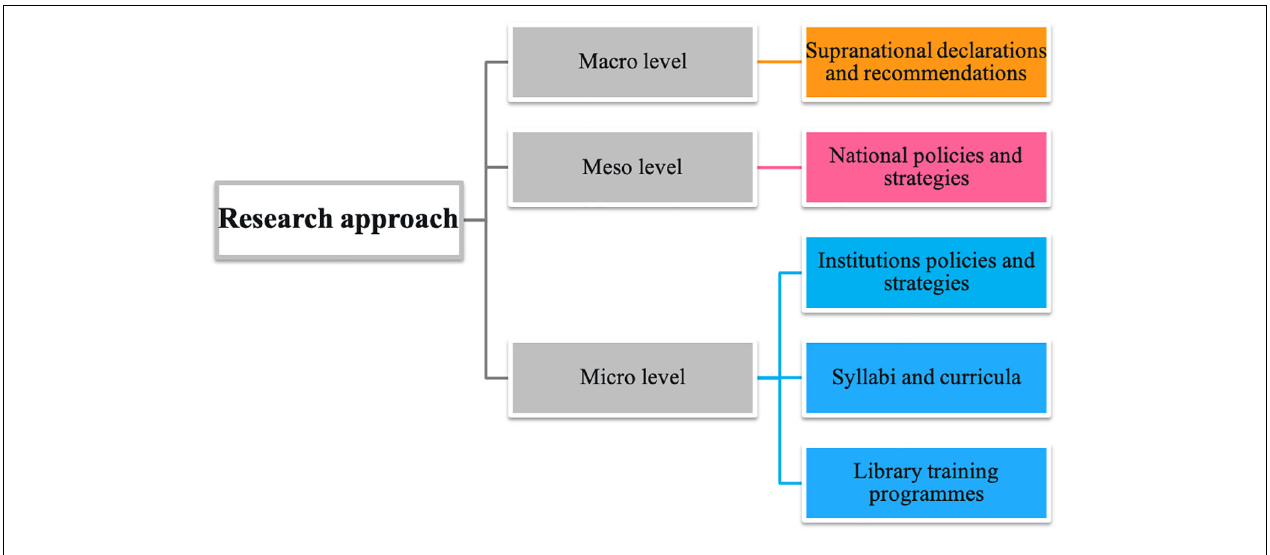
FIGURE 1 | Levels of the research